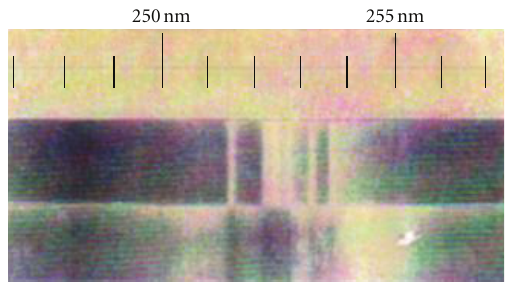
Figure 3: Optical discrete absorption and resonance fluorescence of fused silica in the UV (reproduced from [1]).